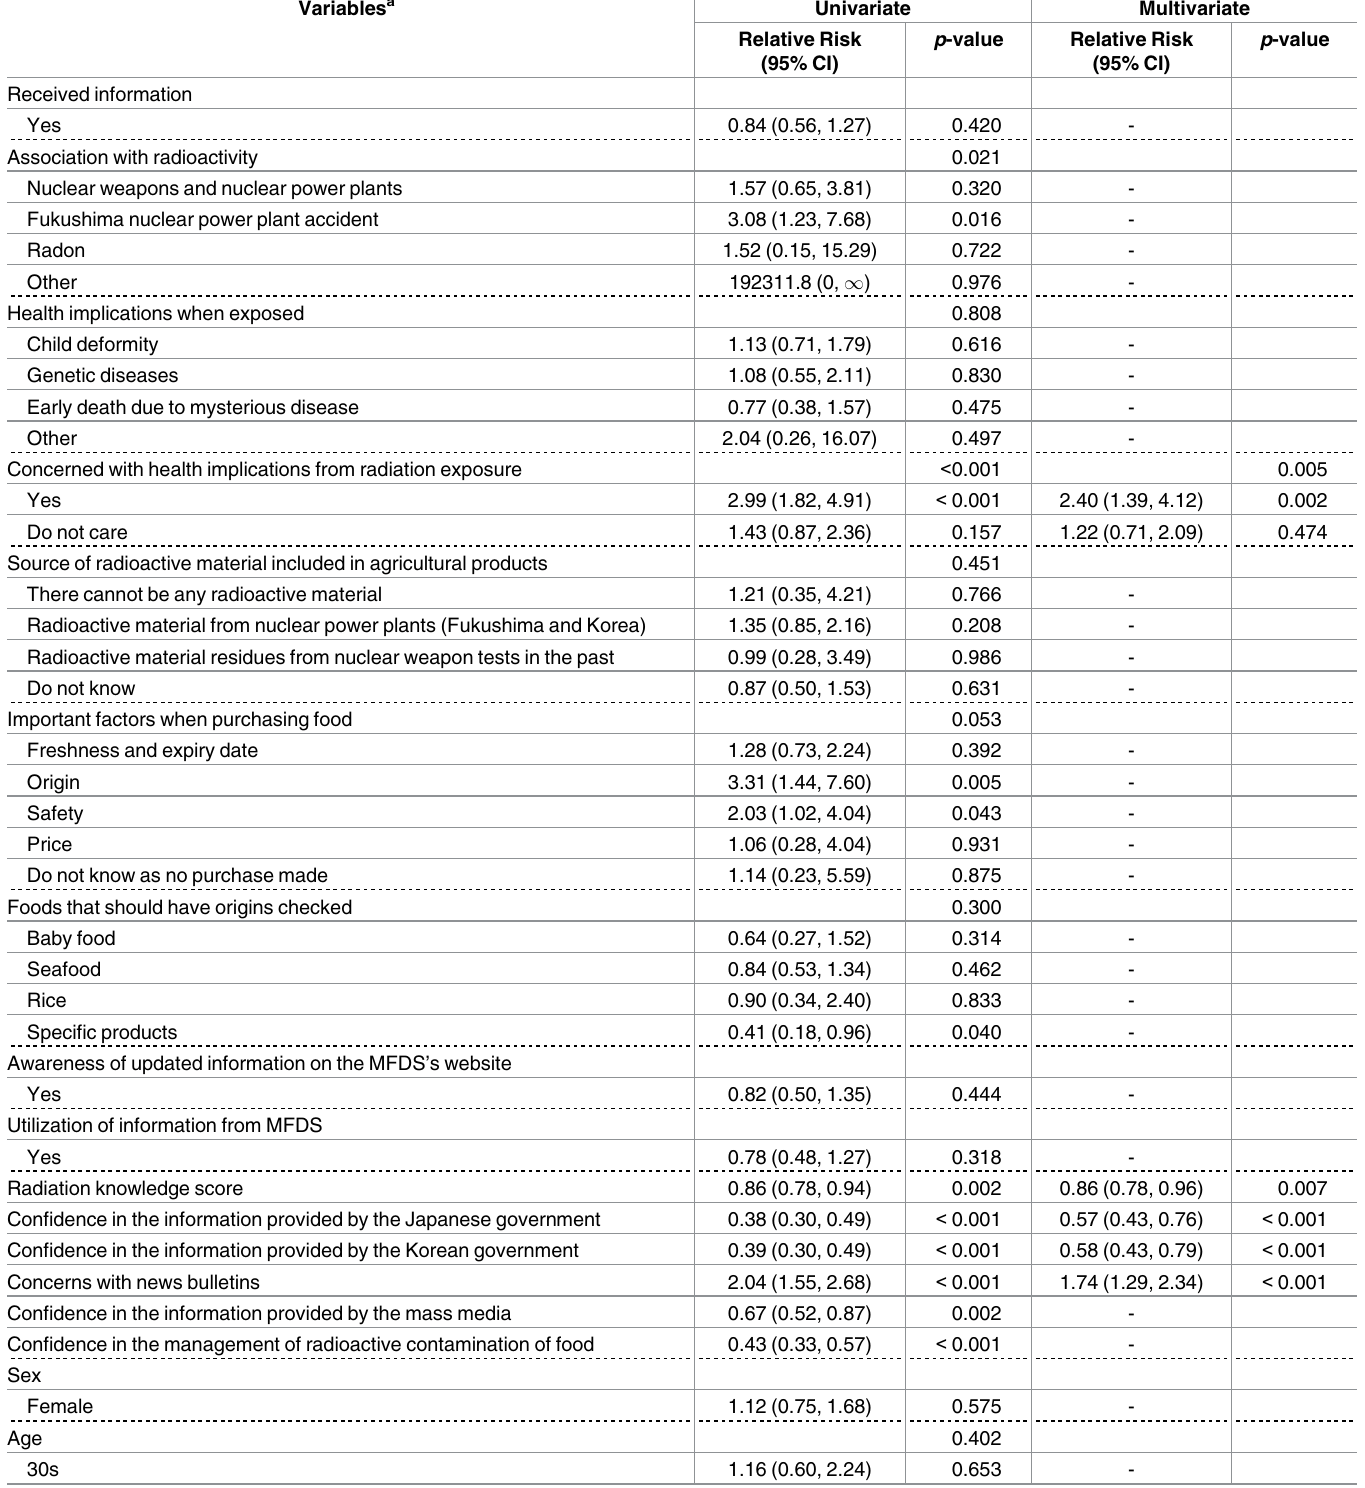
Table 6. Factors associated with non-intention to purchase Japanese seafood with non-detectable levels of